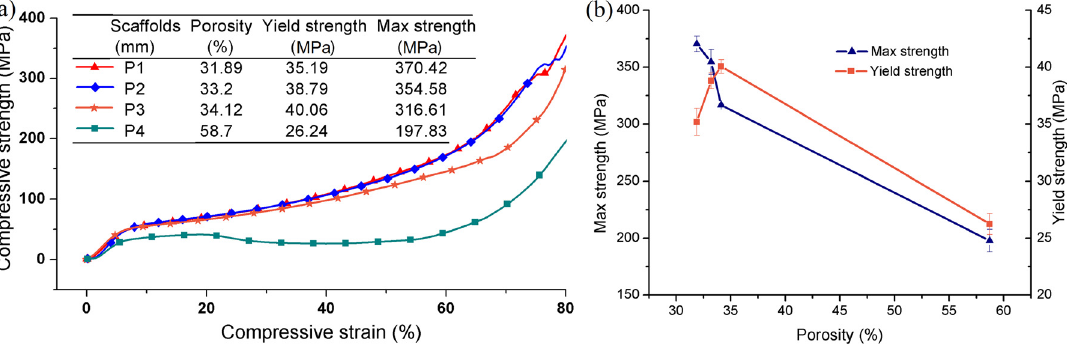
Figure 8: The relationship between: ( a ) strength and strain and ( b ) porosity and strength, modulus ( P1, P2, P3, and P4 represent the scaffolds with pores gradual between 0.4 and 0.8 mm, 0.6 and 1.0 mm, 0.8 and 1.2 mm, and 1.2 and 2.0 mm, respectively ) .